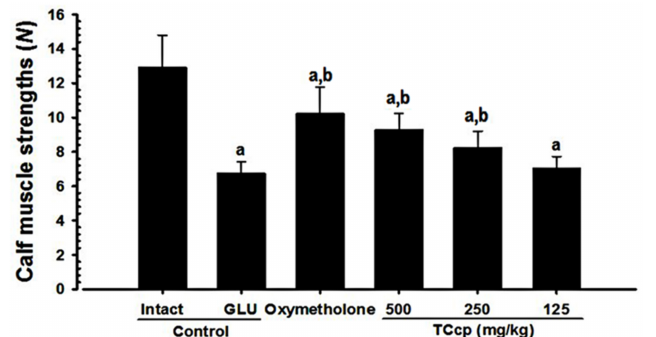
Figure 6. Changes in calf muscle strengths in GLU-induced muscular atrophic mice. Values are expressed means ± S.D. of eight mice. One hour after last (24th) administration of the test materials, the calf muscle strengths of individual mice were measured as tensile strengths using a comput- erized testing machine and expressed as Newton ( N ). TCcp = tart cherry concentrated powder. GLU = glucocorticoid. DEXA = dexamethasone. N = Newton. Oxymetholone (50 mg/kg) dissolved in distilled water was orally administered. a p < 0.01 as compared with intact control by MW test. b p < 0.01 as compared with GLU control by MW test.